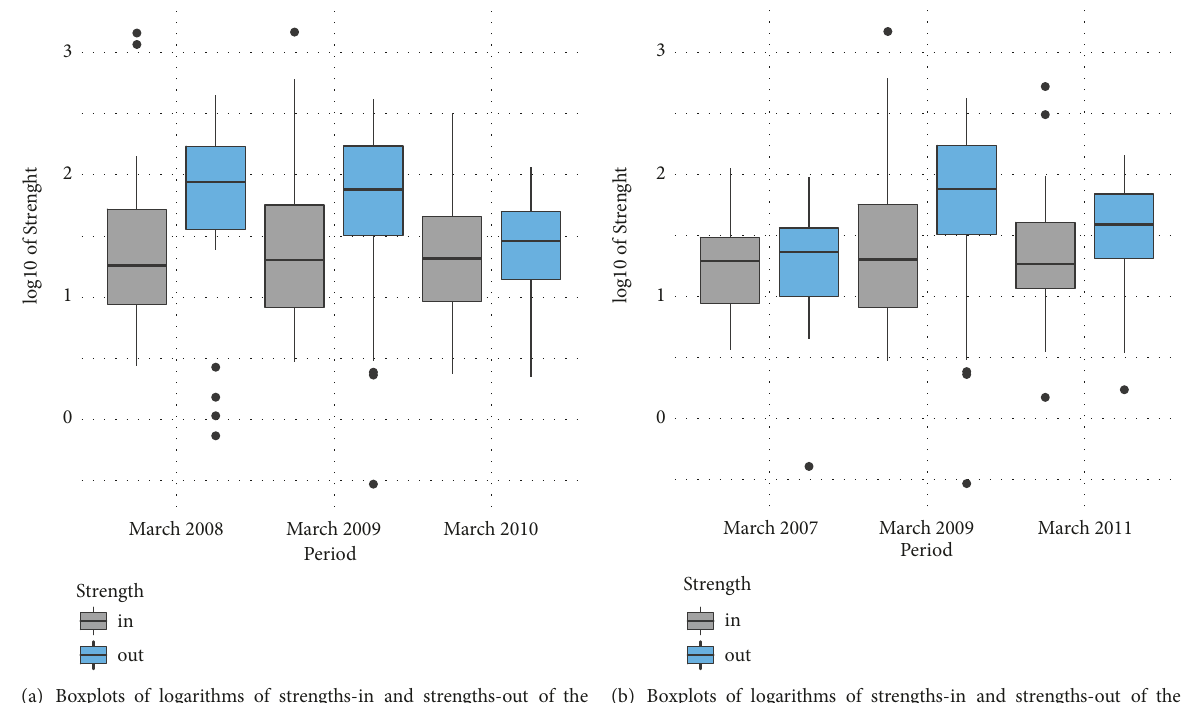
(a) Boxplots of logarithms of strengths-in and strengths-out of the bipartite network projection ofmutual funds, 12 months beforeand after the crisis (March 2008, 2009, and 2010)